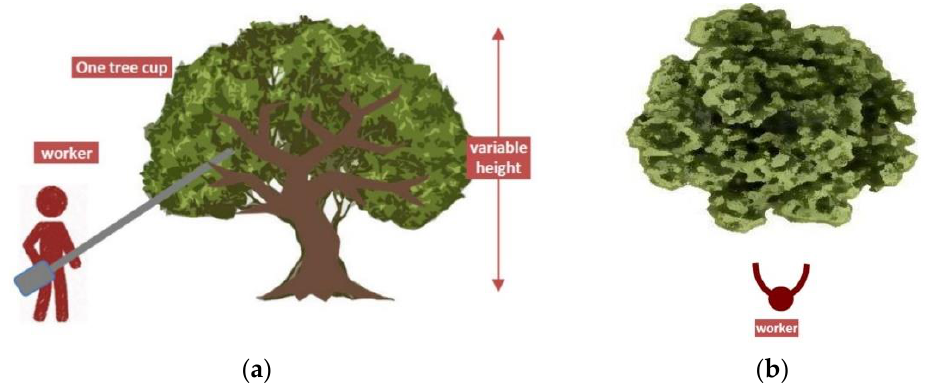
Figure 7. ( a ) Diagram of the worker ’ s position in the lateral view; ( b ) diagram of the worker ’ s position in the front view.